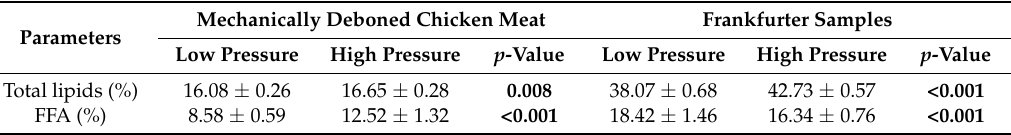
FFA: free fatty acids; p -values with statistically significant differences were highlighted in bold.